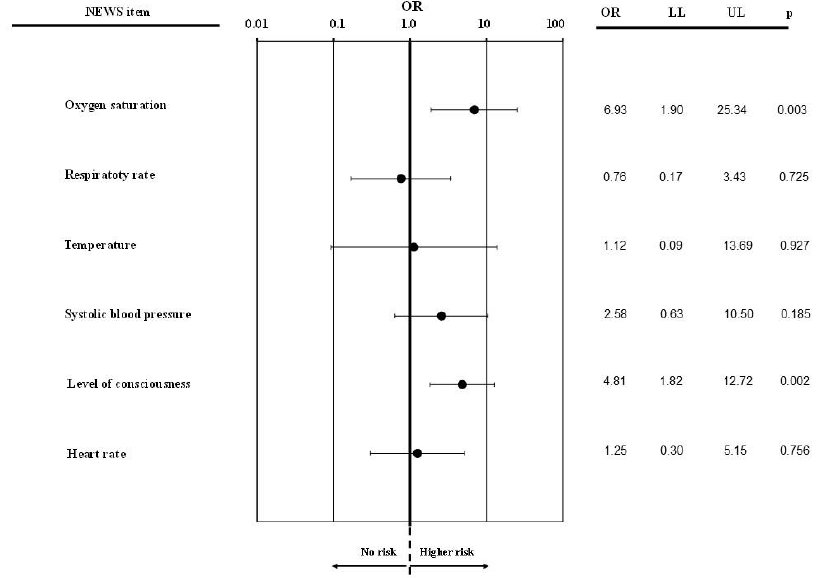
Figure 5. NEWS value with a 3-single parameter and predictors of hospitalization.